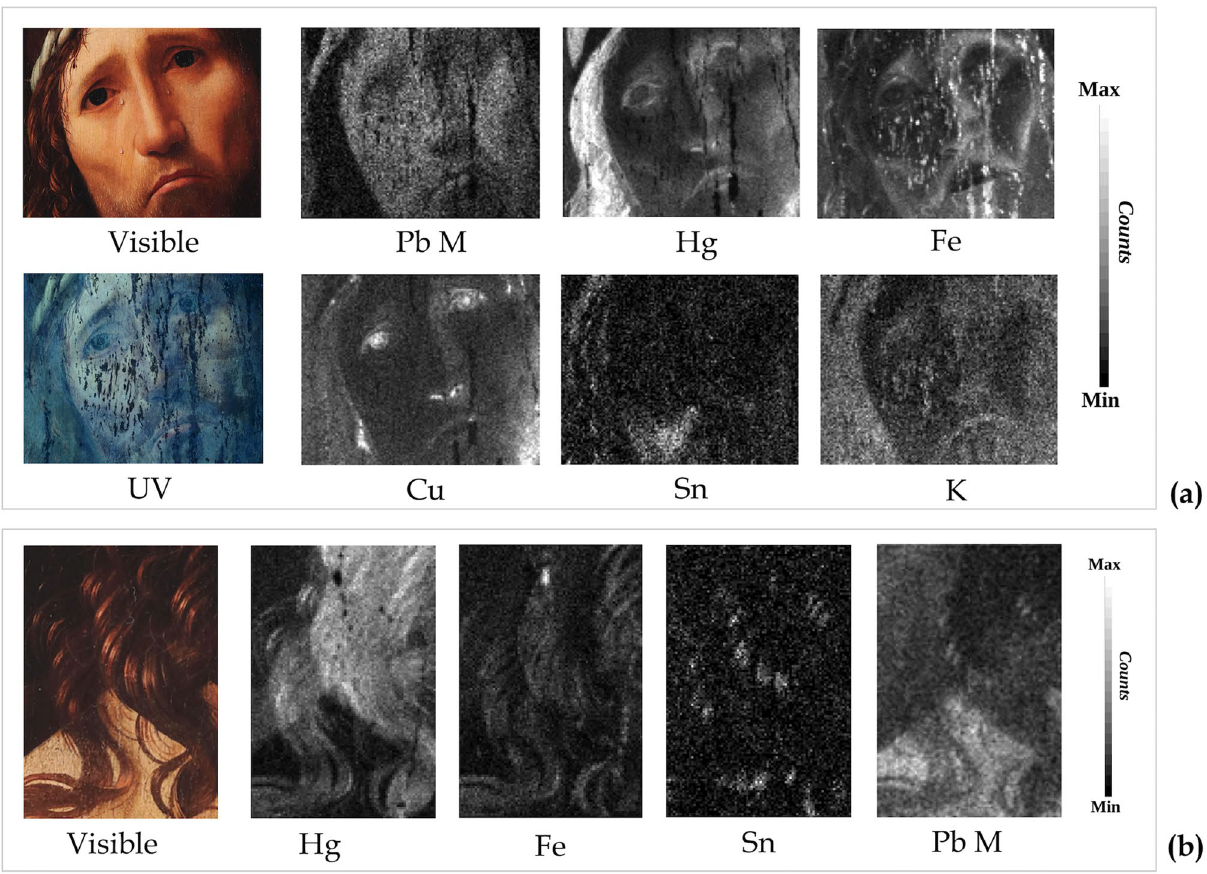
Figure 8. ( a ) Analysis of the Ecce Homo visage (13 × 10.3 cm). Picture in visible light and ultraviolet fluorescence (UV) image of Christ’s visage and elemental maps of the same area obtained by X-ray fluorescence (MA-XRF) mapping analyses. ( b ) Analysis of the right shoulder (4 × 6 cm). Picture in visible light and elemental maps of the same area obtained by X-ray fluorescence (MA-XRF) mapping